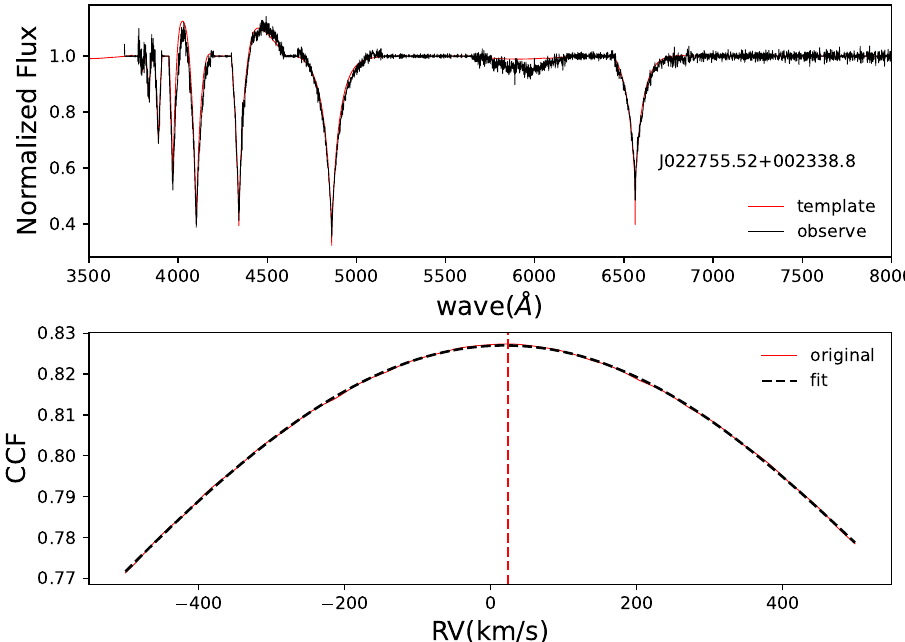
Figure 1. ( Top ): The red solid line indicates the normalized template spectrum, and the black solid line is the normalized observed spectrum. ( Bottom ): The red solid line shows the original CCF curve, the black dashed line shows the fitted CCF curve, and the red dashed line shows the maximum value corresponding to the fitted CCF